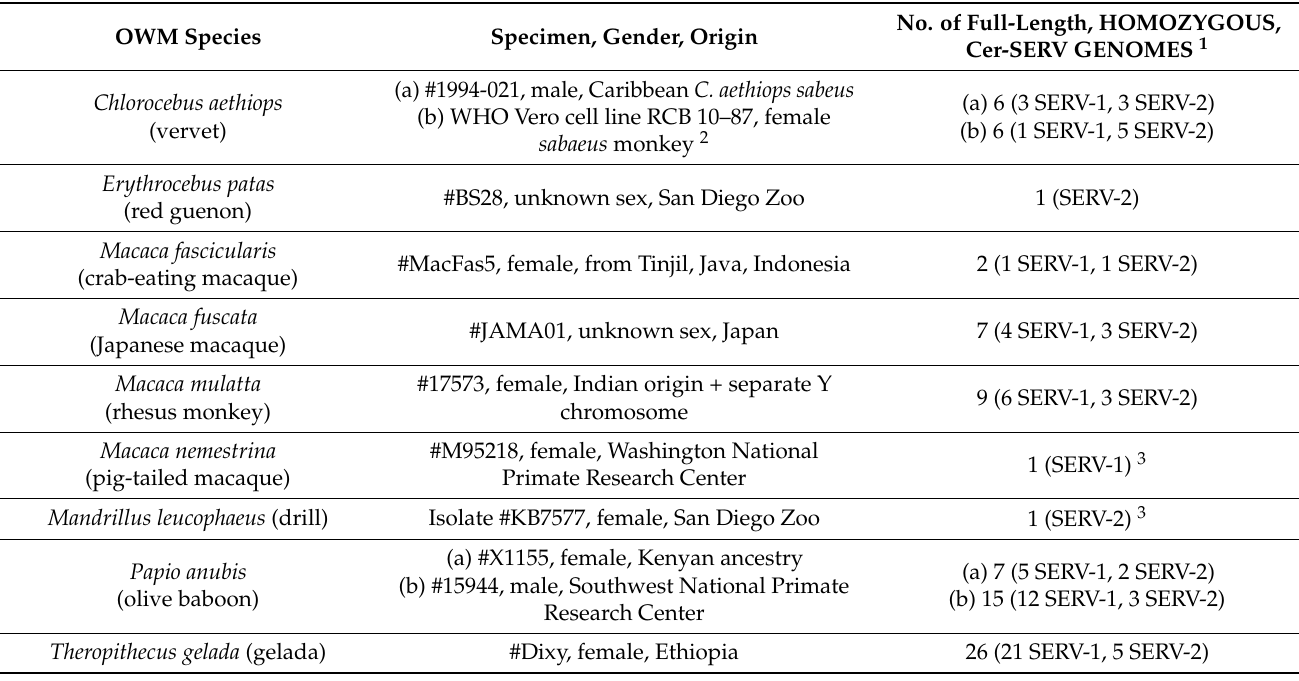
Table 1. Characteristics of OWM genomes queried for SERV sequences, and the number of full-length viral genomes